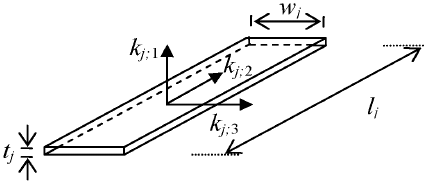
Figure 3: Notations for adhesive bonded joint.